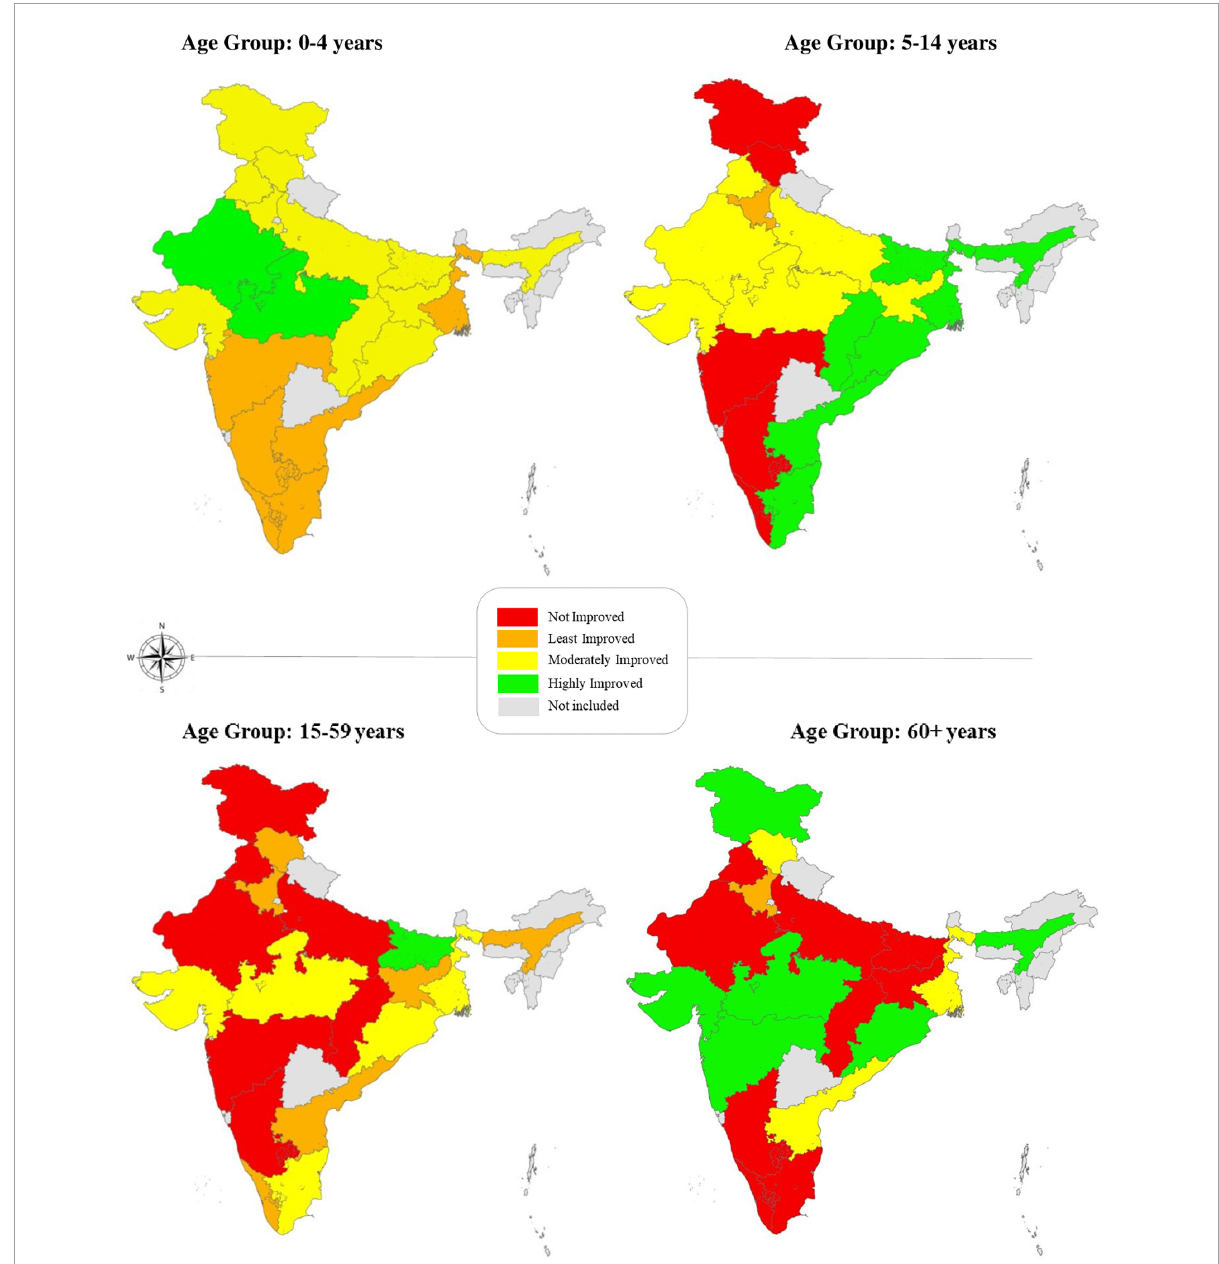
FIGURE1 Mapping of Indian states based on incremental changes in index scores for each component age group. The map has been created using ArcGIS R (cid:13) trial version 10.8 by Esri. ArcGIS R (cid:13)